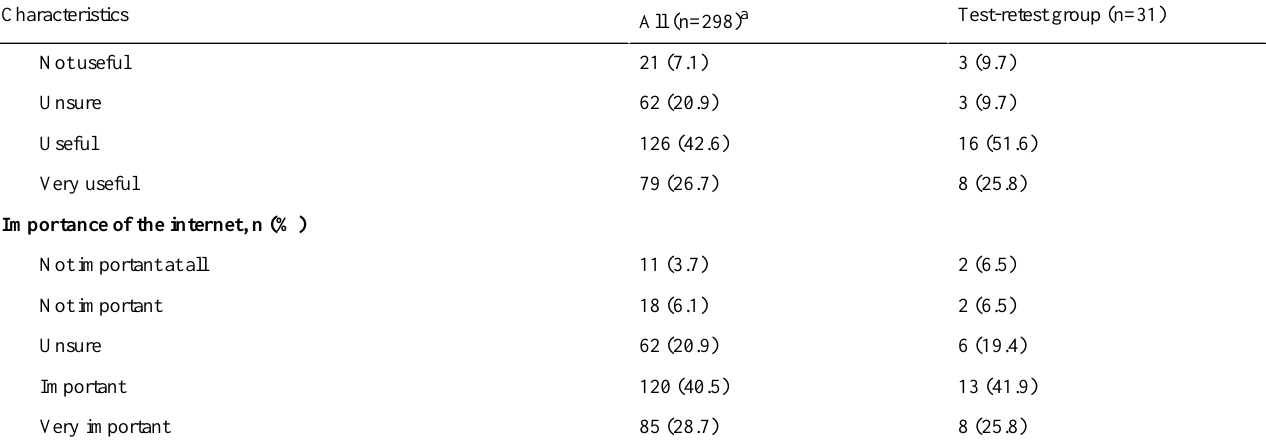
Table 3. Spearman correlations between the Ar-eHEALS sum score and demographic characteristics, questions, and questionnaires.